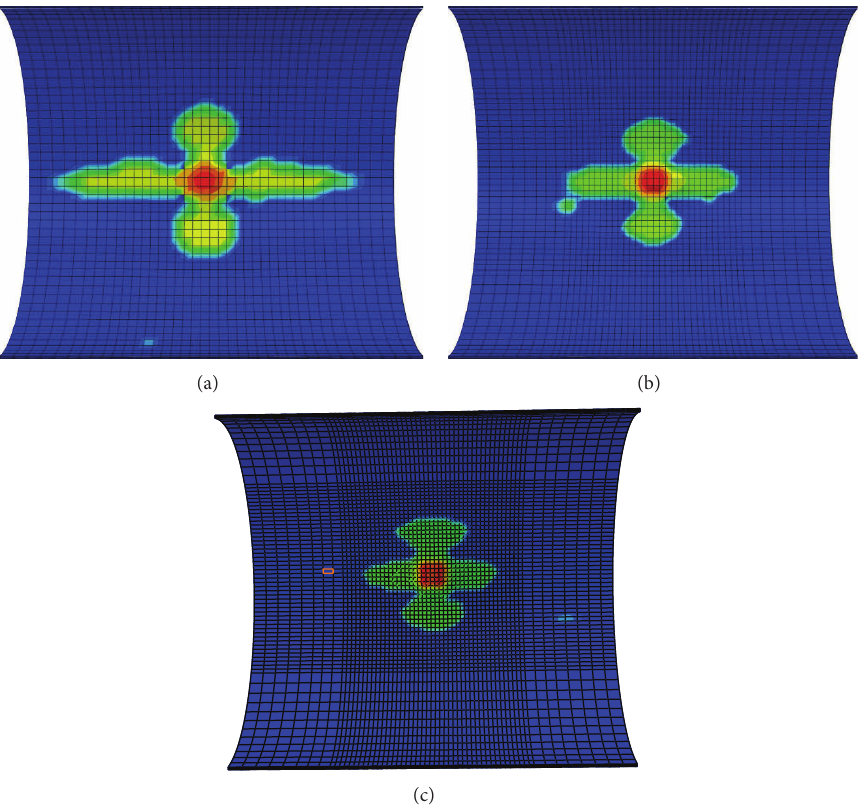
Figure 7: An illustration of the mesh size effects in the FE simulations of hazmat tank car using the local BCJ model. The figures show the damage pattern on the inner surface of the tank located behind the impact region for a coarse (a), medium (b) and fine (c) mesh at the same time. Note the reduction of the damage pattern size with decreasing mesh element size.